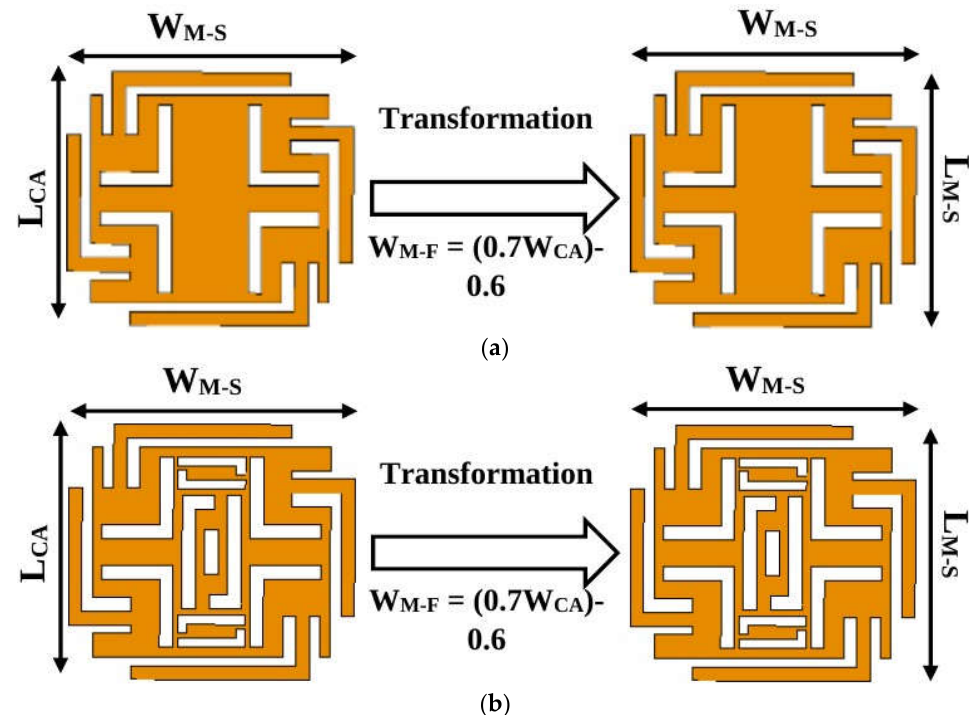
Figure 17. Transformation process of the patch dimensions ( a ) step 3 ( b ) step 4.